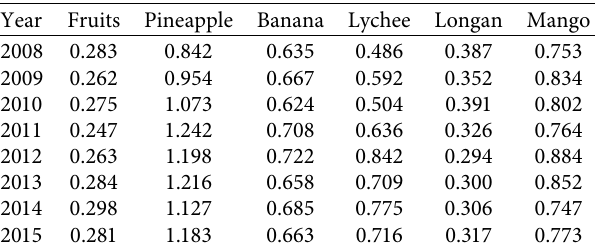
Table 4: The revealed comparative advantage index of Hainan’s exported fruits. Fruits Pineapple Banana Lychee Longan